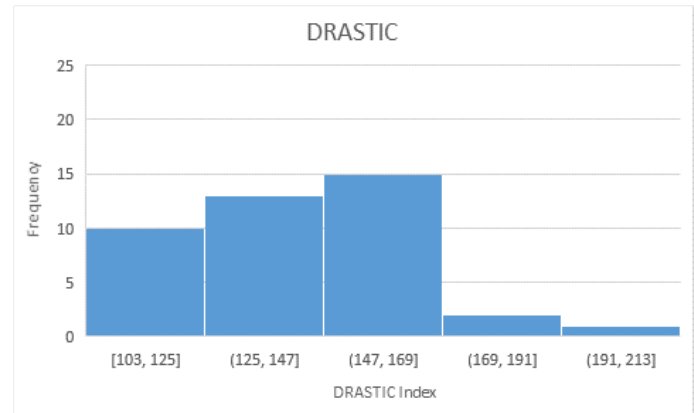
Figure 17. GFR Susceptibility Index.